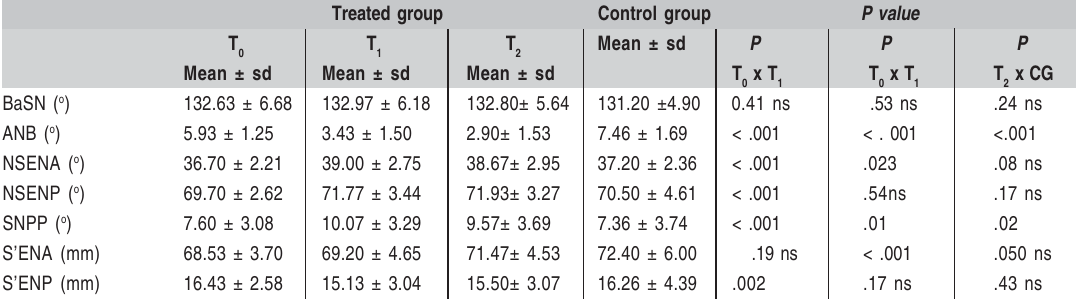
, T and T and in the control group (n=30). 0 1 2